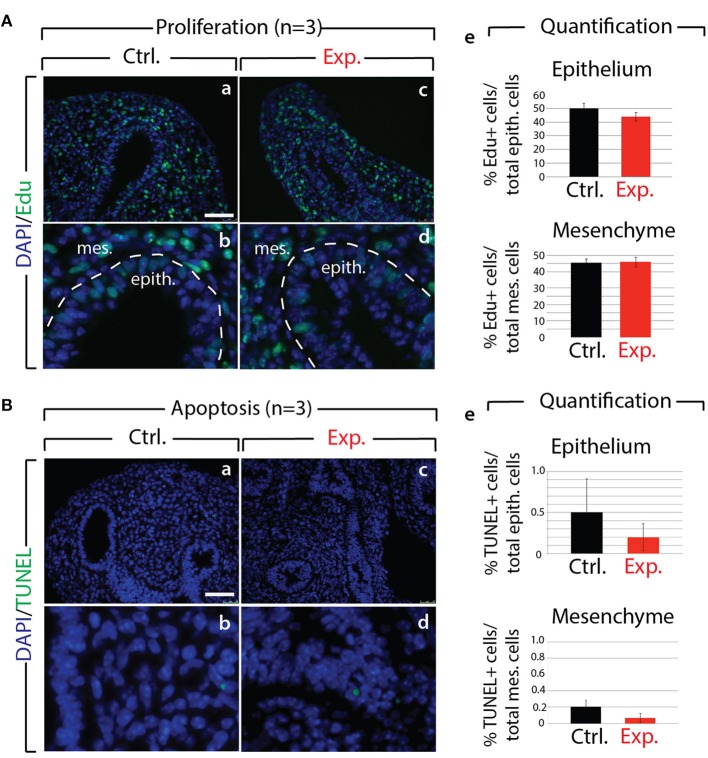
Analysis of proliferation and cell death in control and experimental lungs (A) Proliferation analysis following Edu injection to pregnant females in control (a,b) and experimental (c,d) E12.5 lungs. Quantification of Edu signal indicates no major difference in the number of proliferating cells in control vs. experimental lungs (e). (n = 3) Scale bar: (a,c) 50 μm; (b,d) 17 μm. (B) Apoptosis analysis by TUNEL showing no major difference (e) in the number of apoptotic cells in control (a,b) vs. experimental (c,d) lungs. (n = 3) Scale bar: (a,c) 50 μm; (b,d) 17 μm.